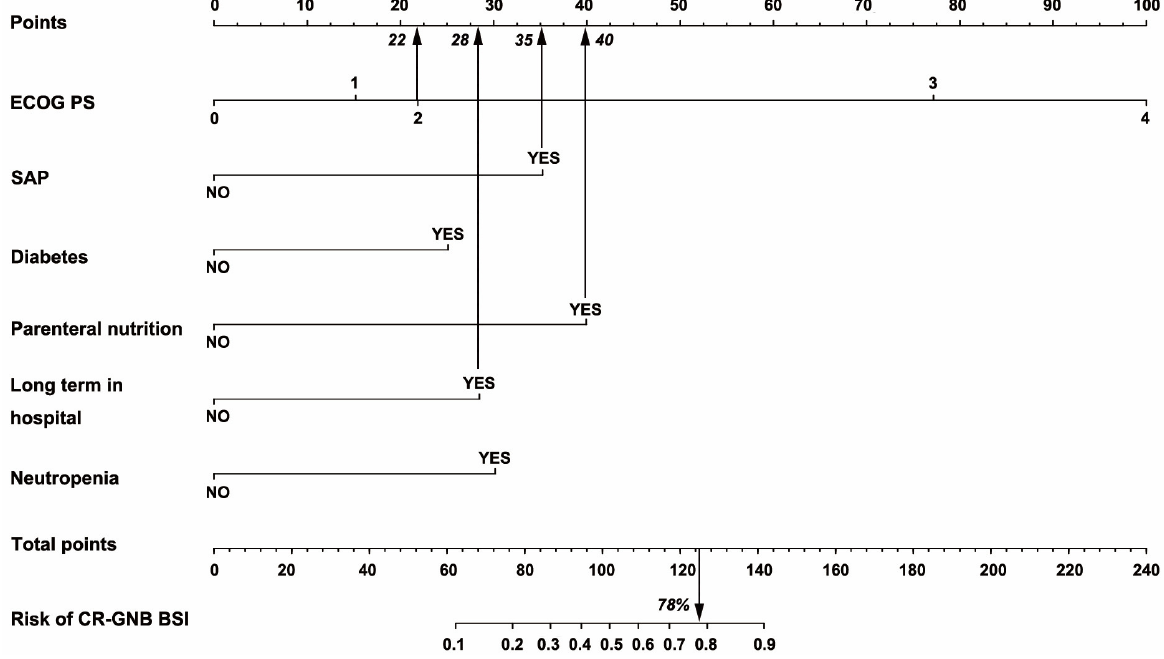
Figure 3. The example of how the predictive nomogram can be used. Abbreviations: ECOG (eastern cooperative oncology group score); SAP (severe acute pancreatitis); CR-GNB (carbapenem resistant Gram negative bacteria); BSI (blood stream infection).